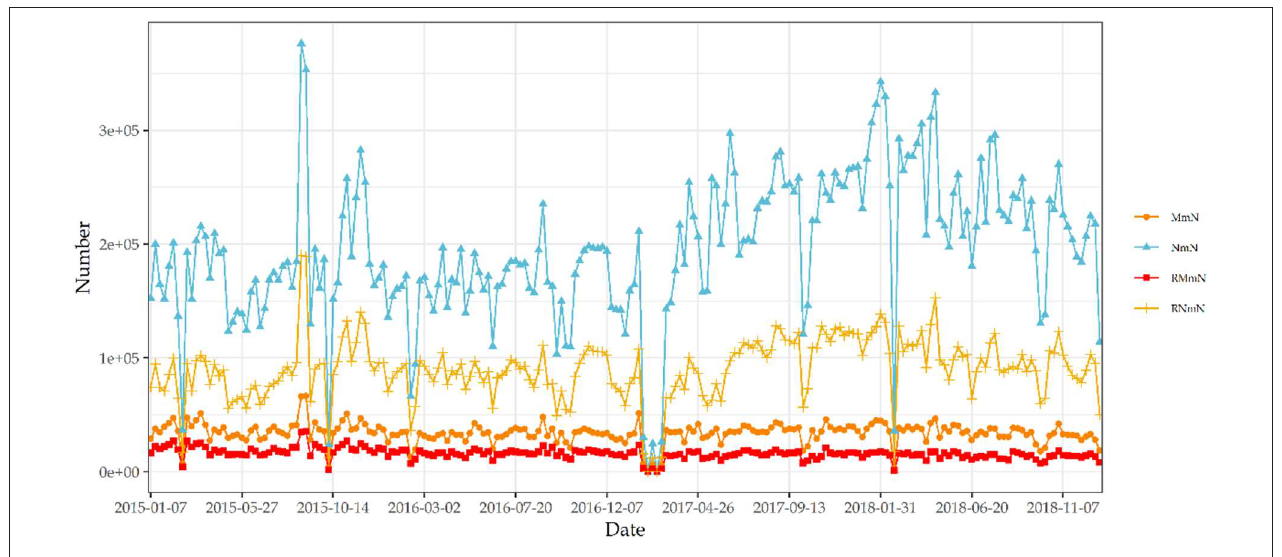
FIGURE 1 | The mean weekly number of four types of news. TABLE 1 | Summary statistics for four types of